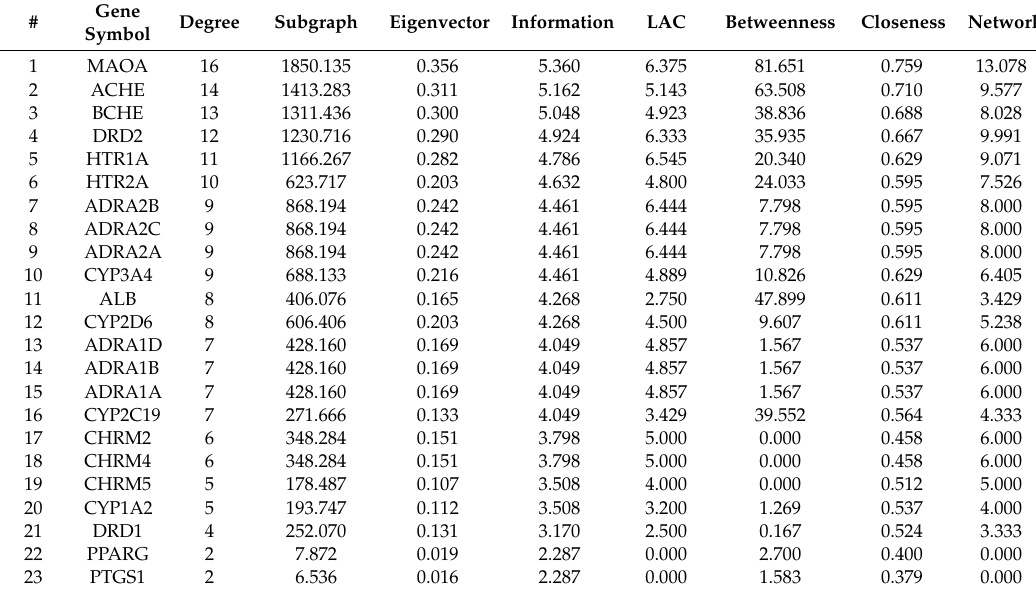
Figure 4. Visualization of the protein–protein interaction (PPI) of the 23 target genes* using STRING and Cytoscape databases. Table 1. Topological analysis of the PPI network of the 23 genes shared by Uncaria alkaloids, AD and hypertension. Data were ranked by degree.